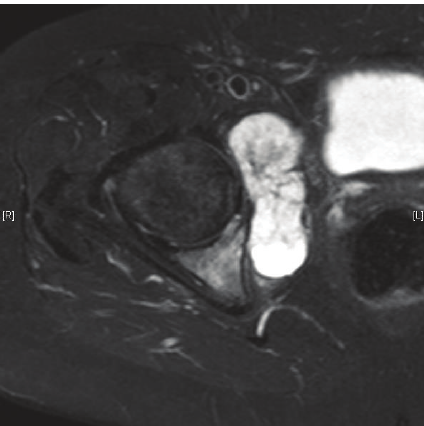
Figure 1: Periacetabular chondrosarcoma with extraosseous exten-